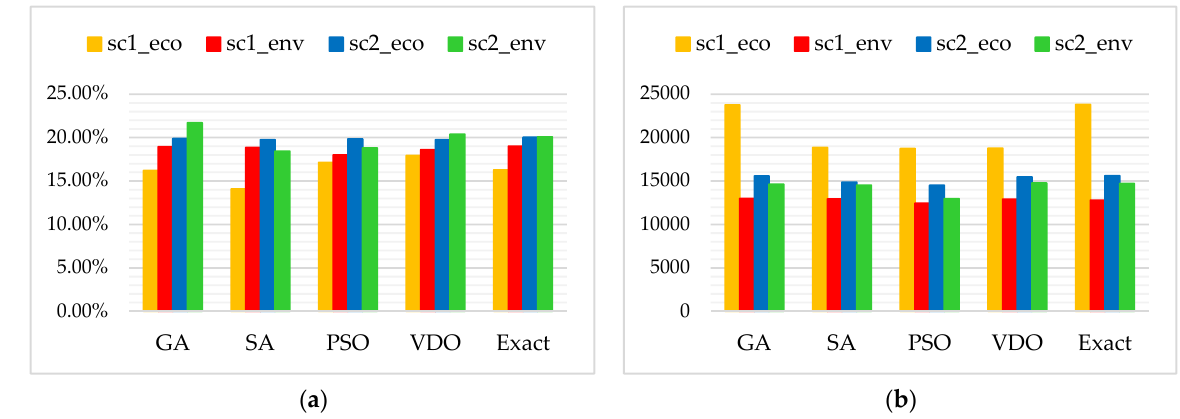
Figure 12. Social/Societal results obtained in the different scenarios. ( a ) Accident risk reduction rate; ( b ) Noise level.